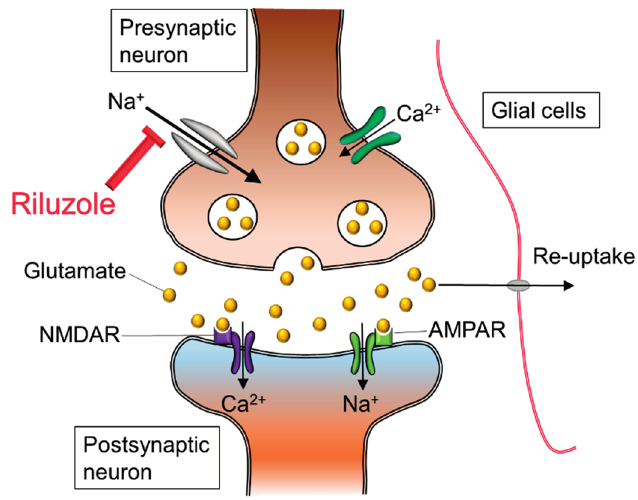
Figure 2. Ionic imbalance and glutamate excitotoxicity. The excessive influx of sodium and calcium triggers extracellular release of glutamate in presynaptic neurons. In the postsynaptic neuron, sodium and calcium influx through NMDAR and AMPAR lead to cellular death and axonal edema. The neuroprotective effects of riluzole appear to result from a blockade of sodium channels, and prevention of exaggerated calcium influx. In addition, riluzole plays a role as an anti-glutamatergic agent via the inhibition of glutamate release in isoxazolepropionic acid receptors: NMDAR; N-methyl- D -aspartic acid receptor, AMPAR; Alpha-amino-3-hydroxy-5-methyl-4-isoxazole propionic acid